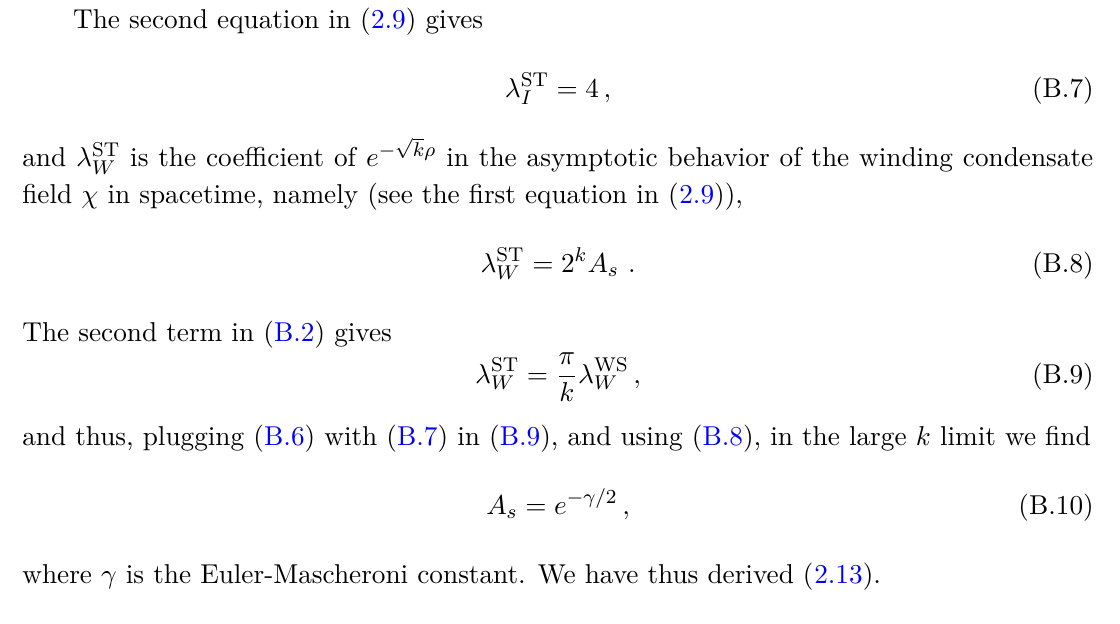
(0) on the left s